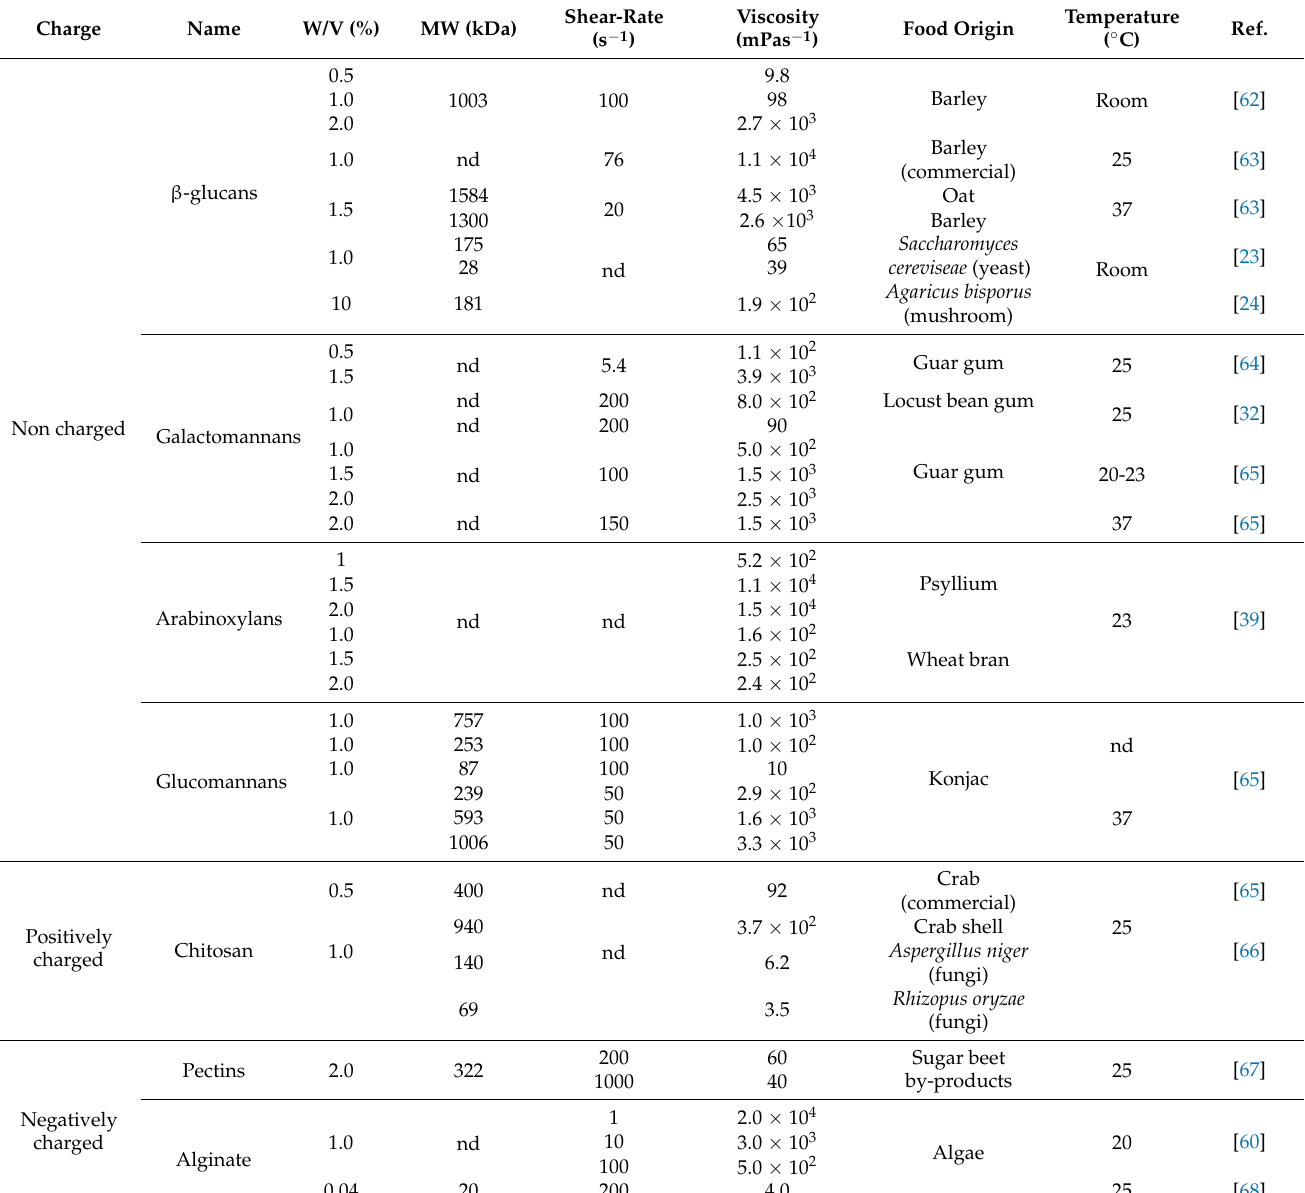
Table 1. Non charged and charged polysaccharides’ viscosity dependence on concentration, molecular weight, shear rate and raw material